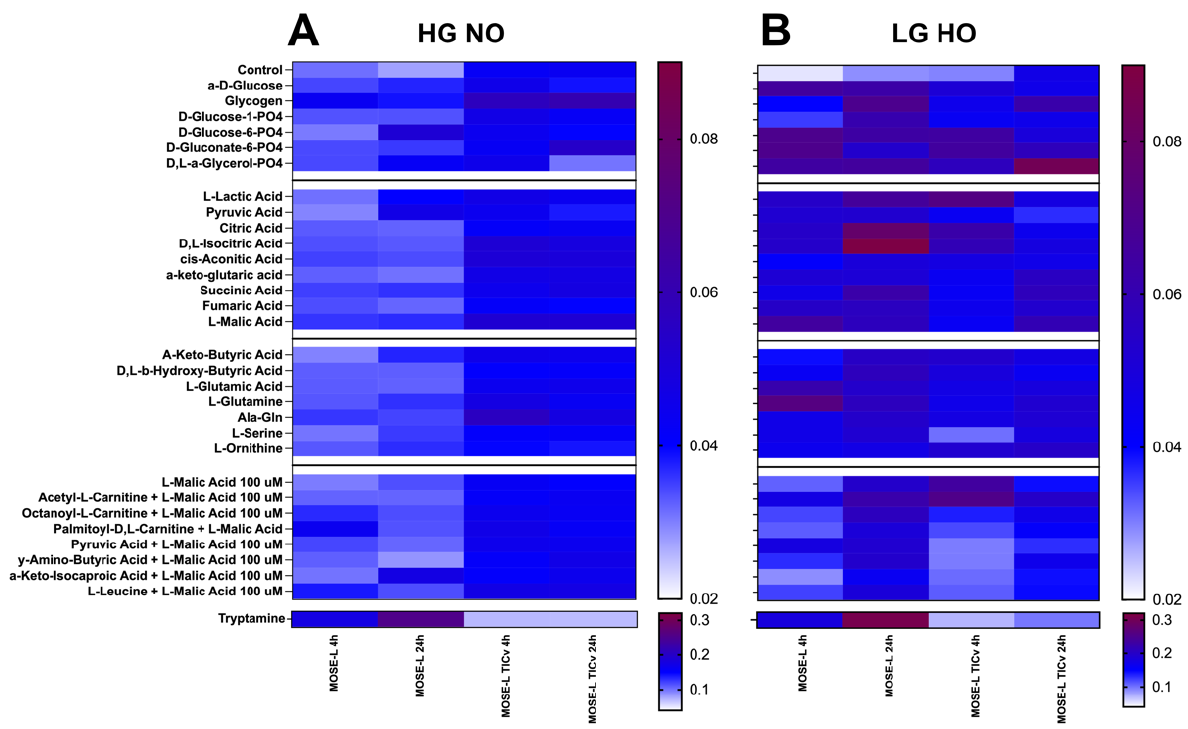
Figure 7. Substrate utilization using MitoPlates™ heat map. Differential utilization of substrates for energy production from intermediates for glycolysis, the TCA cycle, and fatty acid oxidation shown through colorimetric redox assay for MOSE-L and MOSE-L TICv at 4 and 24 h of adherence in ( A ) HG NO and ( B ) LG HO. Tryptamine heat map is shown at the bottom of ( A , B ) with its own heat map quantification scale. Abbreviations: high glucose (HG); low glucose (LG); normoxia (NO); hypoxia (HO).